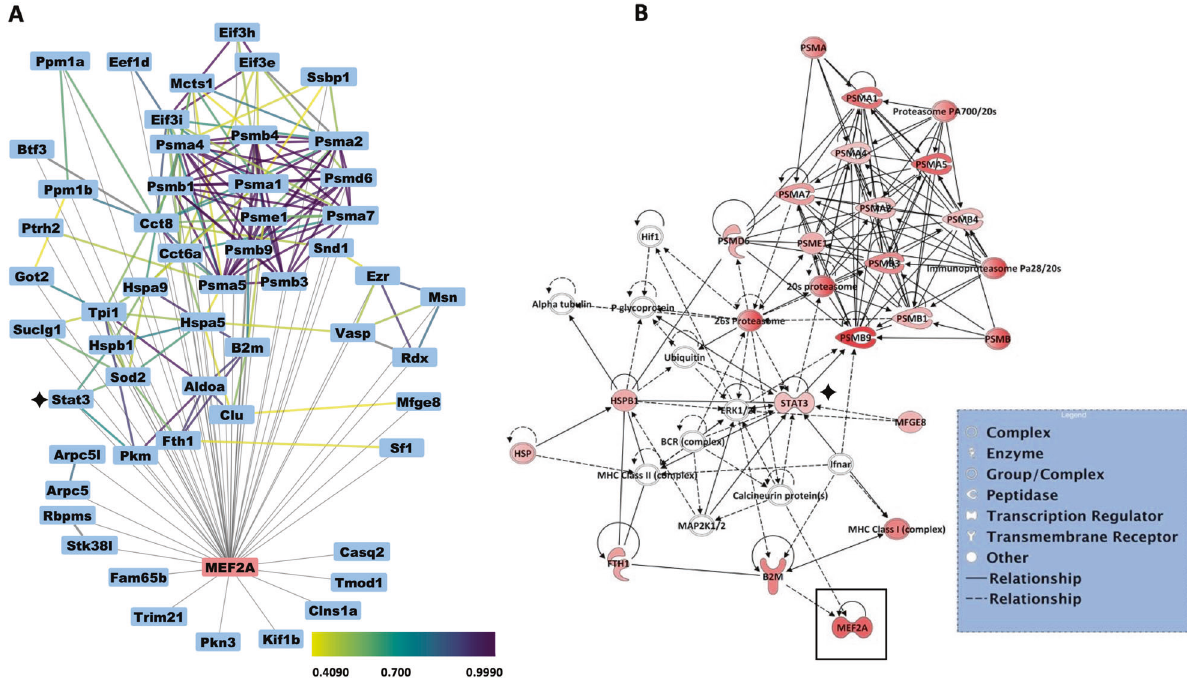
Fig. 2 Protein networks associated with 56 enriched MEF2A interactors. A The network between identi fi ed proteins is built using the STRING database using con fi dence level of 0.4 (default setting) and with no additional interactors. The edge color corresponds to the con fi dence score depending on the database, as de fi ned in the legend. The gray edges are added to the network and represent the novel protein-protein interaction network identi fi ed by our study. Node position and edge length and width are created arbitrarily. B The top scoring IPA protein networks ‘ Gene expression, RNA Damage and Repair, RNA Post-Transcriptional Modi fi cation ’ is depicted for the highly enriched proteins in MEF2A complex in PCMs. The shape of the node represents the molecular type of the proteins as de fi ned in the legend. The red color intensity represents the magnitude of enrichment of the protein in the MEF2A complex. The protein interaction networks were generated with IPA (QIAGEN Inc., https://www.qiagenbioinformatics.com/products/ingenuity-pathway-analysis/). STAT3 gene is marked by a black star in both